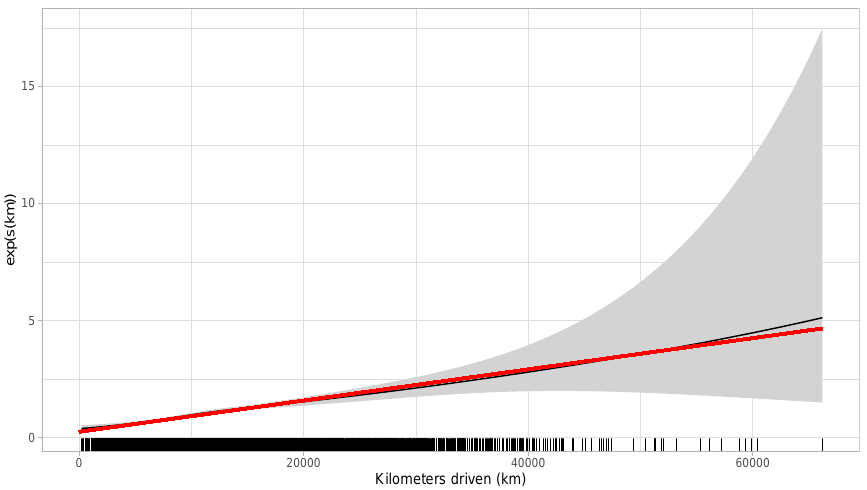
Figure 12. GAM with fixed effects estimated with Canadian